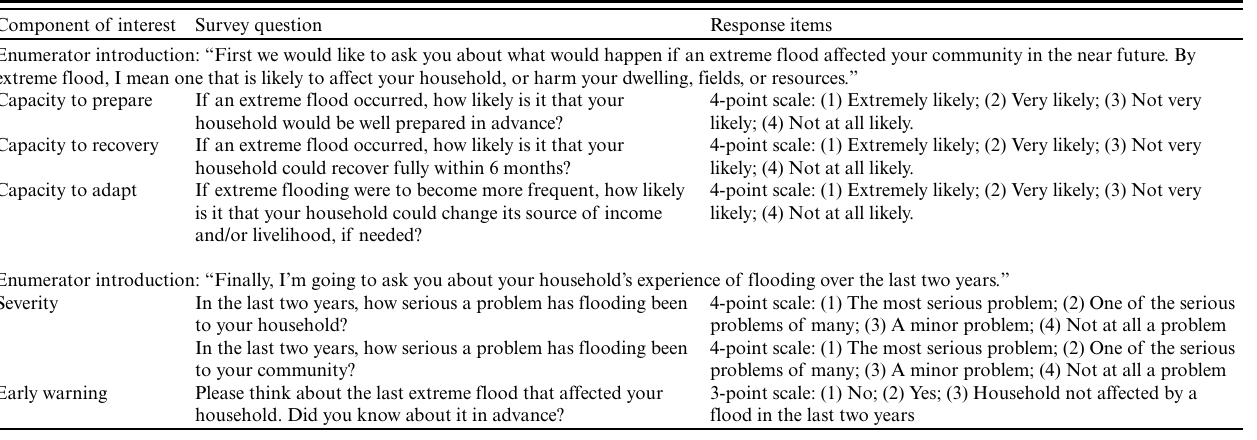
Table 1 . Resilience-related questions administered through the national